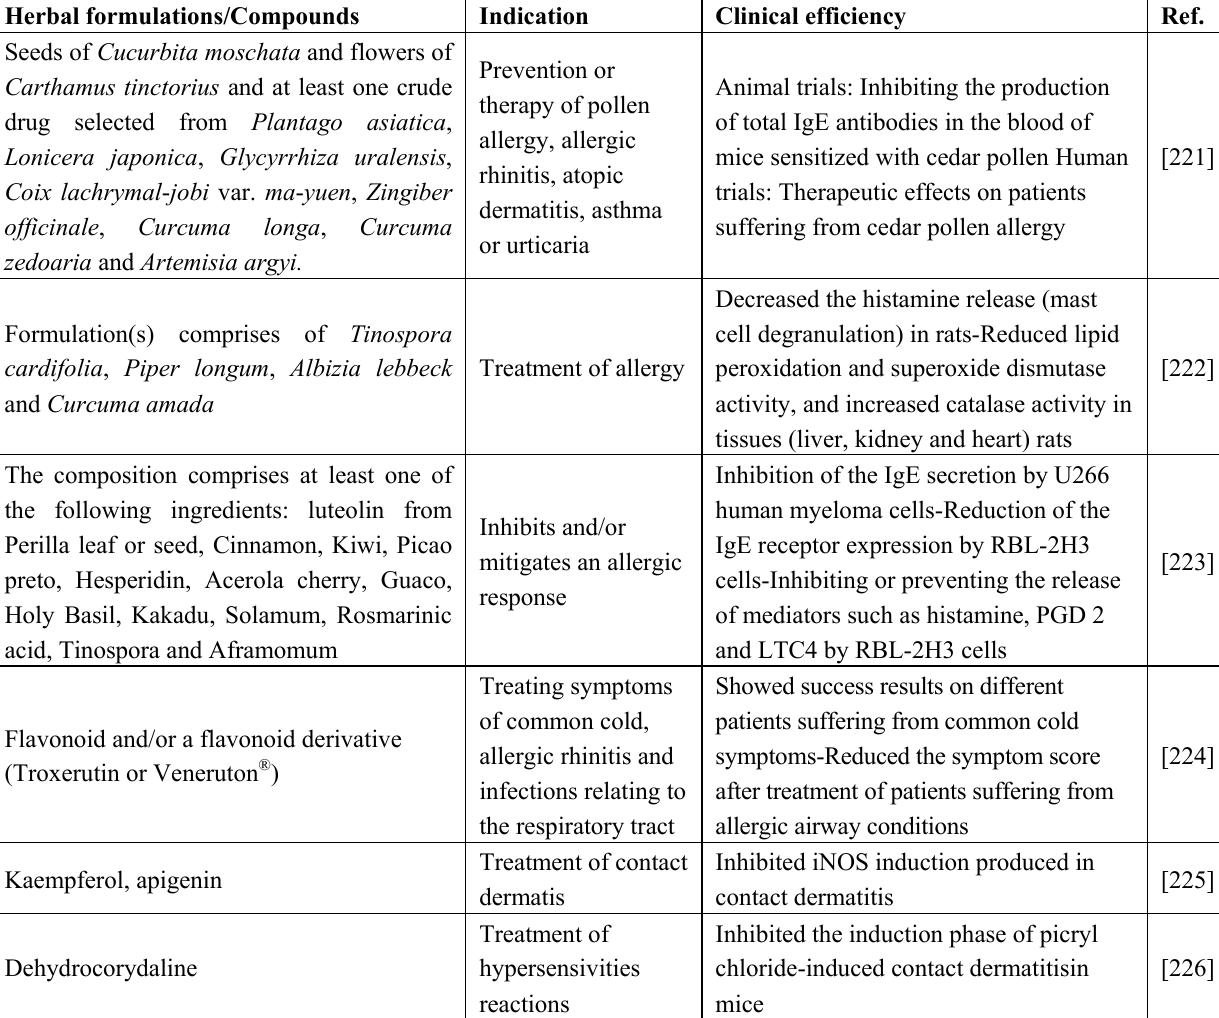
Table 4. Phytochemicals with anti-allergic effects and their clinical